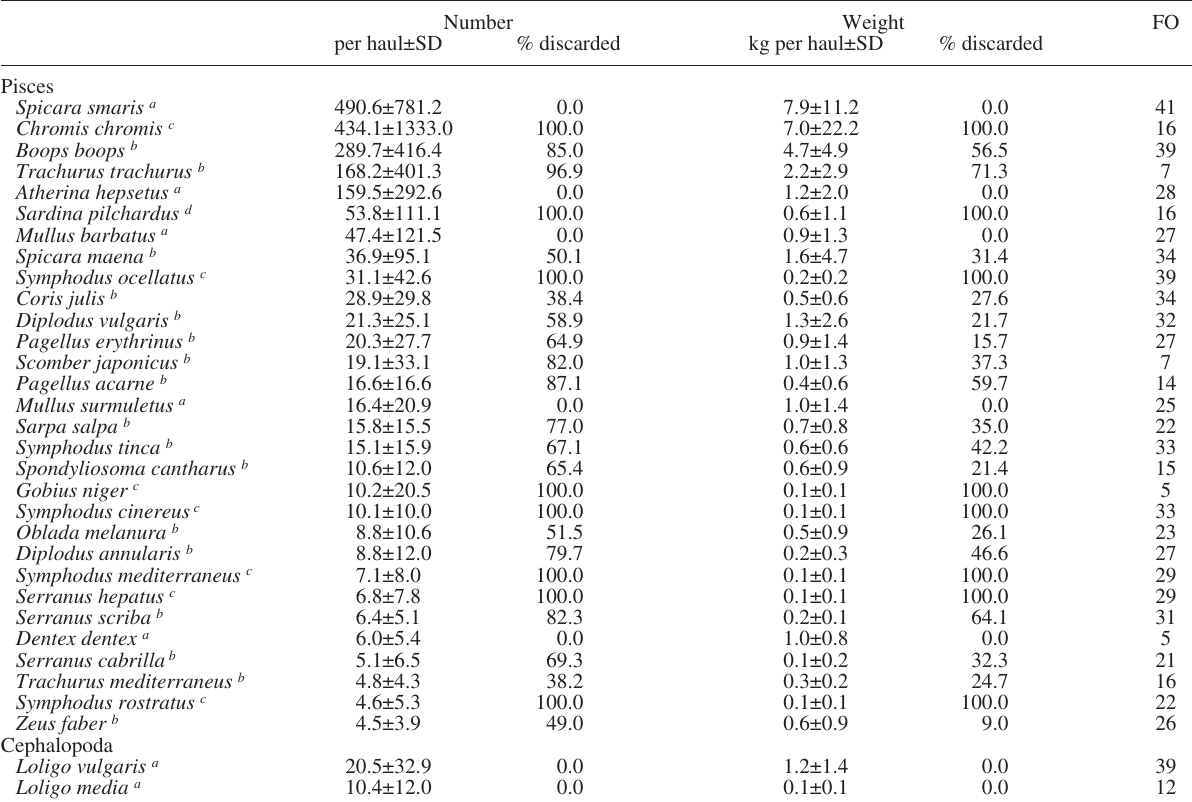
Table 1. – Mean (±SD) number and weight per haul, discard percentages and frequency of occurrence (FO – number of hauls in which species occurred) for the most abundant species in boat seine catches on Posidonia beds (eastern Adriatic). Number Weight FO per haul±SD % discarded kg per